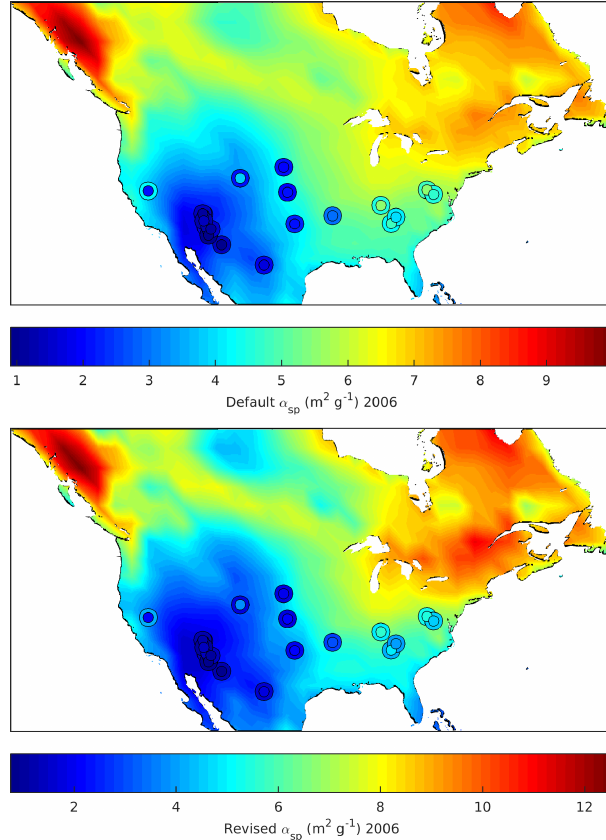
Figure 10. Average relative and absolute change in GEOS-Chem mass scattering efficiency over North America for the year 2006 after implementing revised optical tables for secondary inorganic and organic aerosols.